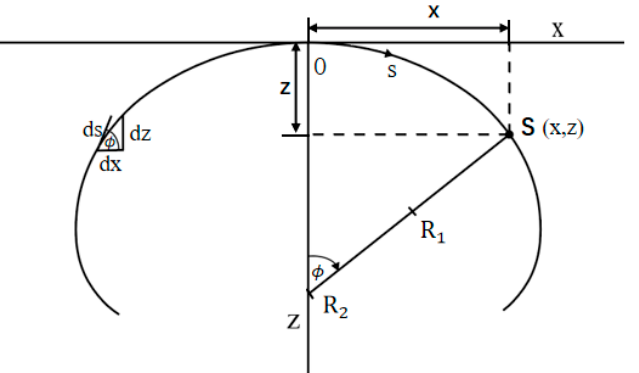
Figure 1. Schematic diagram of an axisymmetric heavy droplet and its geometrical